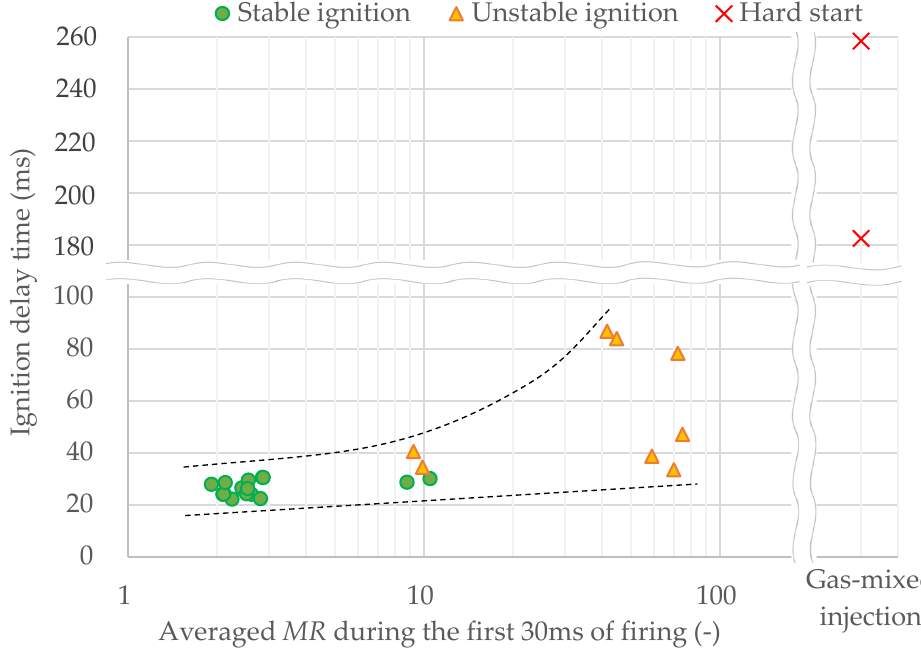
Figure 19. Relation between early averaged MR and ignition behavior.